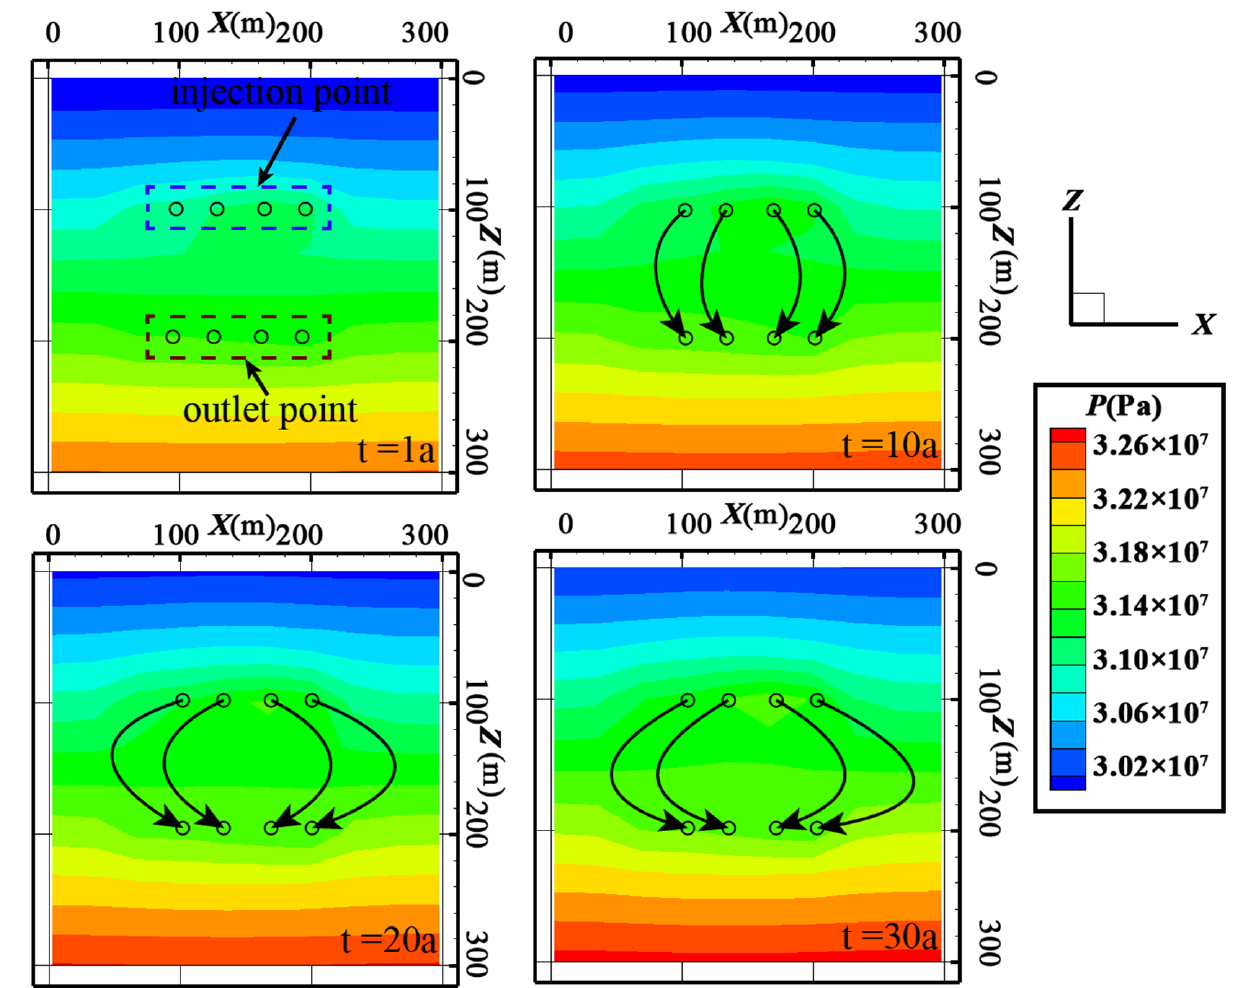
Figure 19. Pressure distribution for the horizontal wells.